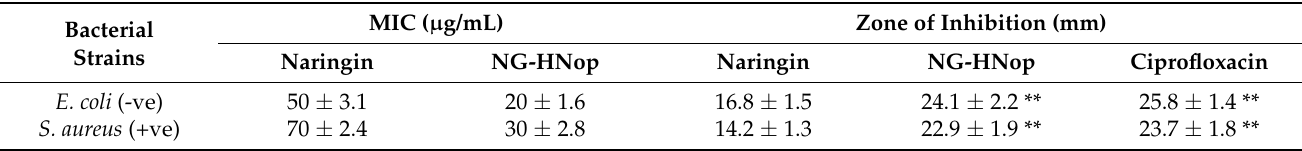
Table 5. MIC and zone of inhibition results for pure Naringin (NG) and Naringin hybrid nanoparticles (NG-HNop). The study was performed in triplicate and data are shown as mean ± SD. **—Highly significant with respect to pure